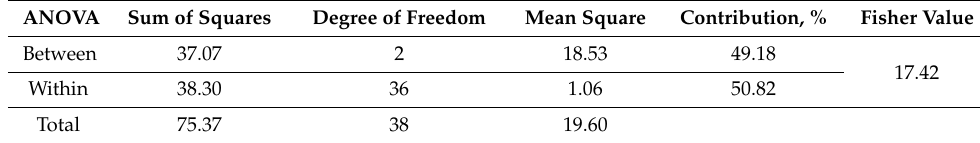
Table 6. Comparison between Groups A, B and C in